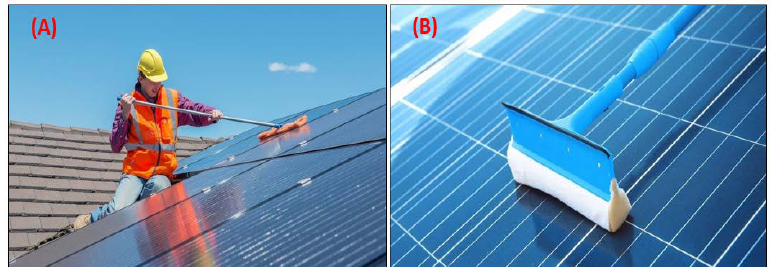
Figure 8. Manual cleaning process of the PV panels. ( A ) Using a soft brush with distilled water and dish soap, ( B ) using a soft brush.